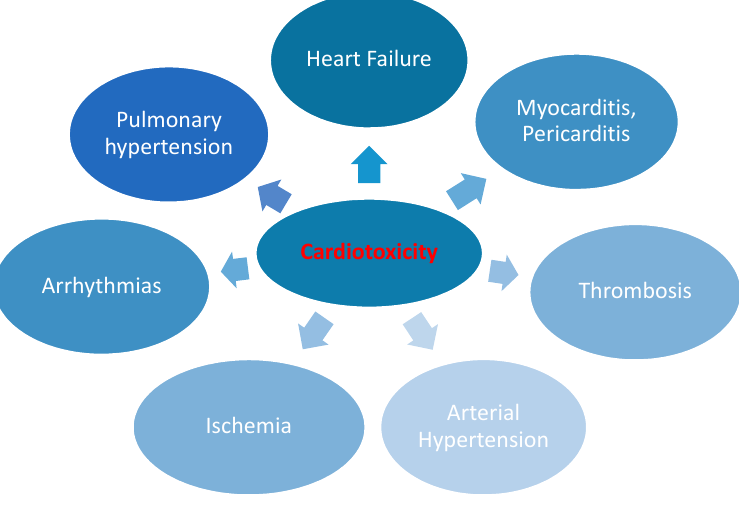
Figure 1. Cancer therapy-related cardiotoxicity [4,9]. Table 1. Major anticancer agents—mechanisms and clinical manifestations of cardiotoxicity [4,10–18].